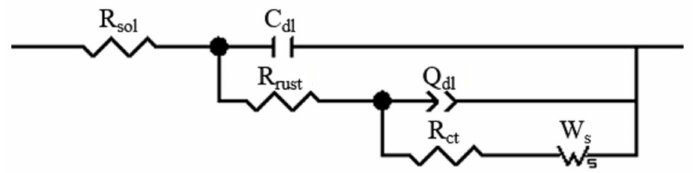
Figure 9. Equivalent circuit of the rusty samples in 0.01 mol/L NaHSO 3